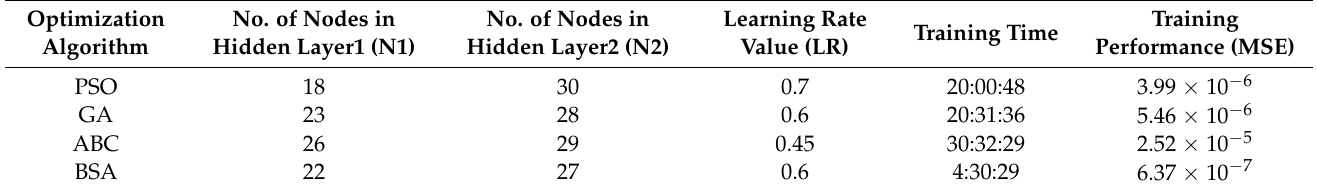
Table 13. Artificial neural network training-based PSO, GA, ABC, and BSA using the optimized parameters obtained. Optimization